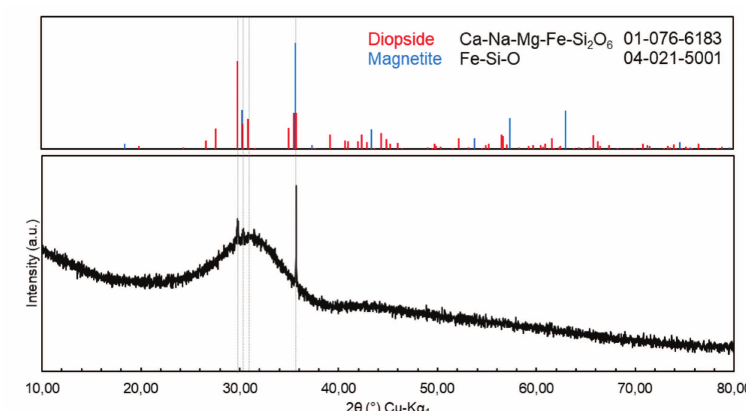
Fig. 4. X-Ray diffractogram of the wasteform WL ox = 40